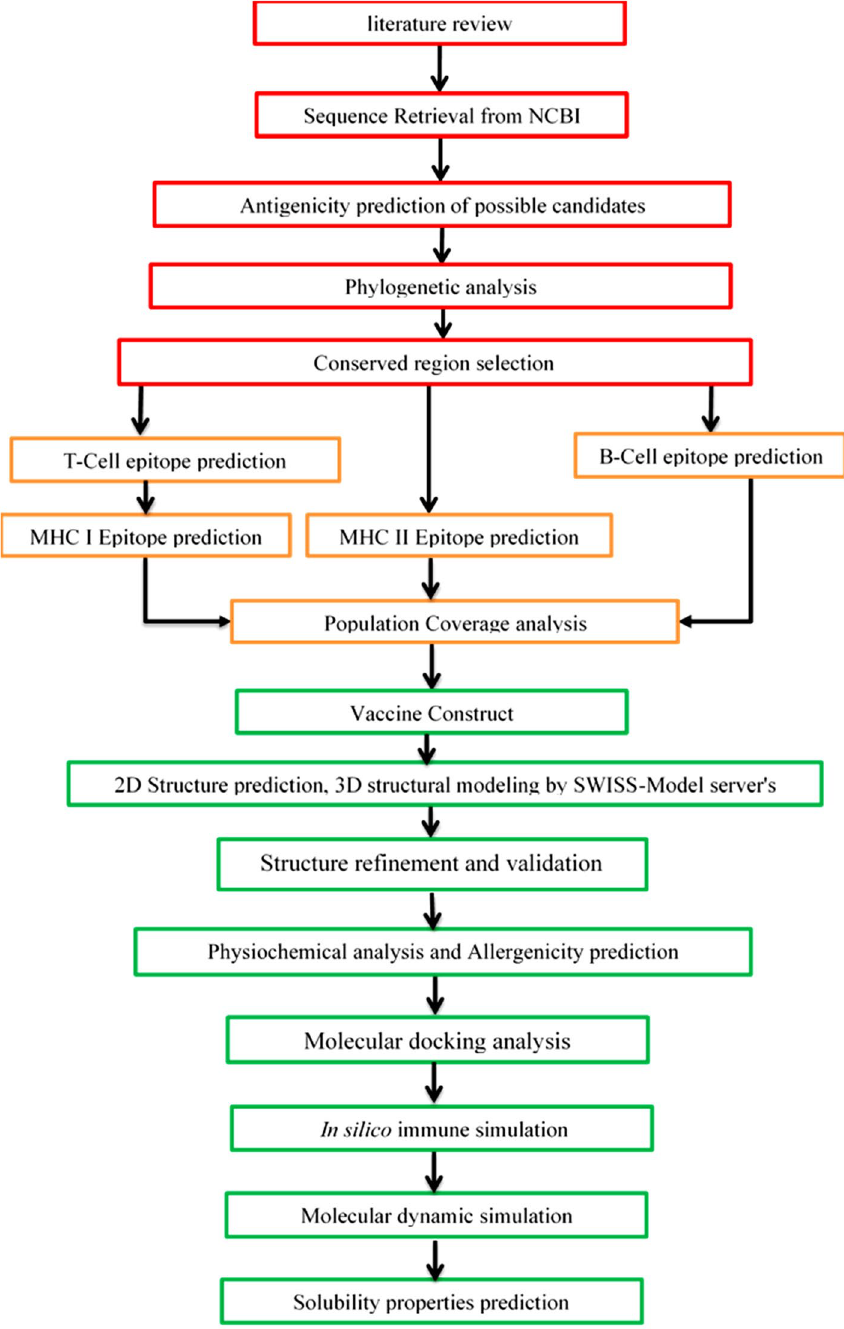
Figure 1. Demonstrated the immunoinformatics approaches used for vaccine design against